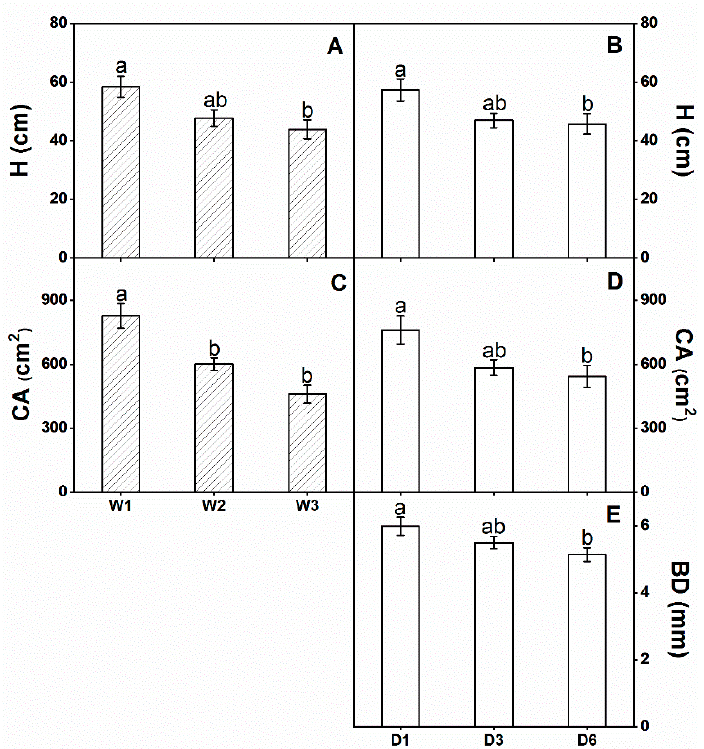
Figure 3. H, CA, and BD at the end of the experiment in R. pseudoacacia seedlings subjected to rainfall intensity and rainfall frequency treatments (mean ± SE, n = 6). Bars ( A , C ) in the left graphs are the rainfall intensity treatments (W1, W2, and W3: 75%, 55%, and 35% of field capacity, respectively). Bars ( B , D , E ) in the right graph represent the rainfall frequency treatments (D1, D3, and D6: every day, every 3 days, and every 6 days of watering, respectively). Different letters denote significant differences at p ≤ 0.05 by Tukey’s-HSD test.